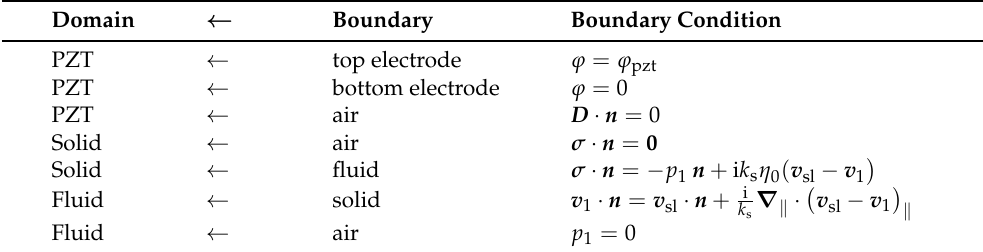
Table 1. The boundary conditions used in the numerical simulations with the surface normal vector n pointing away from the respective domain. We use the solid velocity v sl = − i ω u , and